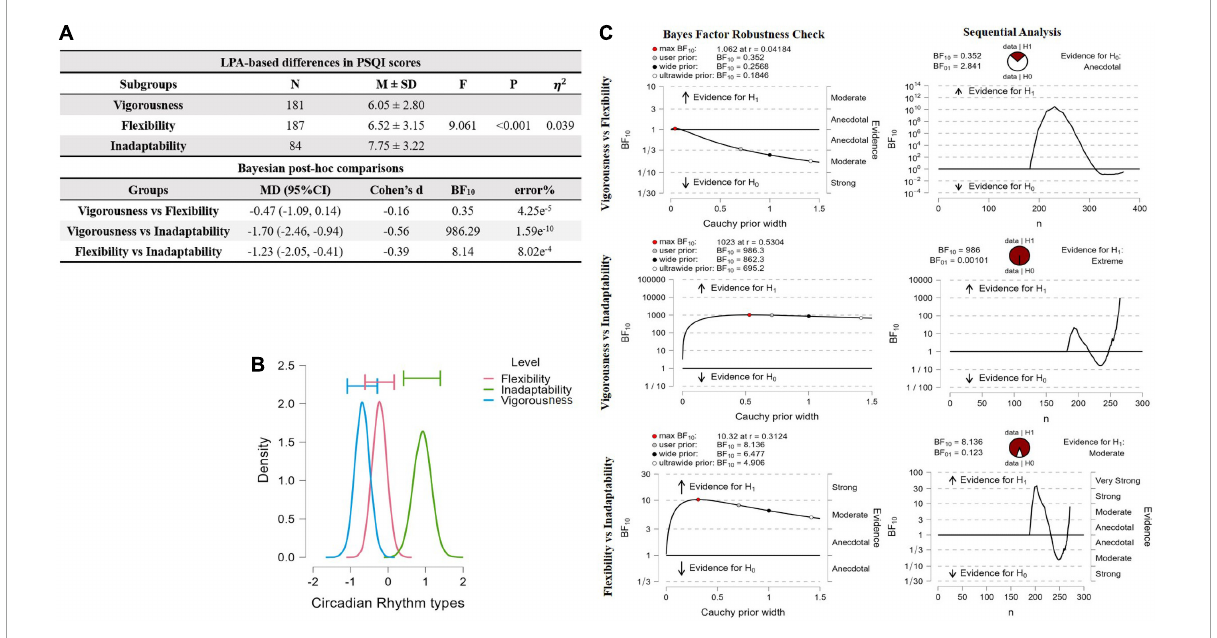
FIGURE4 ANOVA comparison of PQSI scores across LPA-based groups and post hoc comparison by Bayesian factor analysis. (A) LPA-based differences on PSQI scores were estimated by Bayesian Factor. V, Vigorous group; F, flexibility group; I, inadaptability group; SD, standard deviation; MD, mean difference; BF, Bayes Factor; η 2 , eta squared represents the explained unique variance of a dependent variable by three homogenous subgroups. (B) ANOVA model averaged psterior distribution. (C) Inferential plots for Bayesian factor analysis.